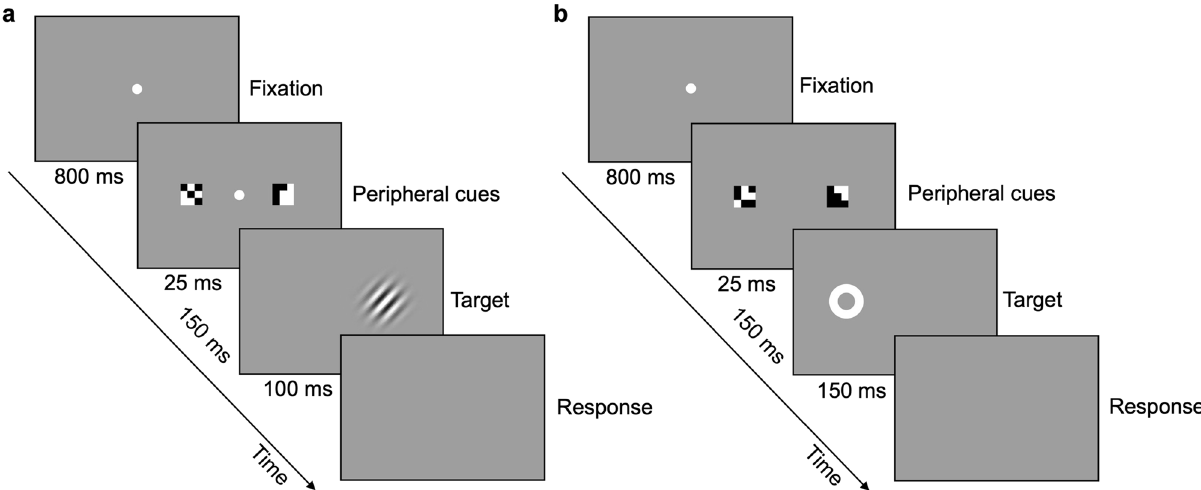
Figure 2. Procedure. (a) Covert-attention task. Example of non-neutral trial of the experimental condition, in which the optimal feature (the one on the right) precedes the target presentation (valid trial). Target is a ± 20°-tilted gabor (40 pixels large, 1.5 cm diameter, spatial frequency of 2 cycles per degree, sigma of 5.7, phase of 0.5π). (b) Gaze-orienting task. Example of non-neutral trial of the experimental condition, in which the optimal feature (the one on the right) is presented on the opposite side of the saccadic target (invalid trial). Target is a circular white placeholder, 100% contrast, 9 pixels large (0.3 cm diameter). Cues and targets are shown oversized for illustration